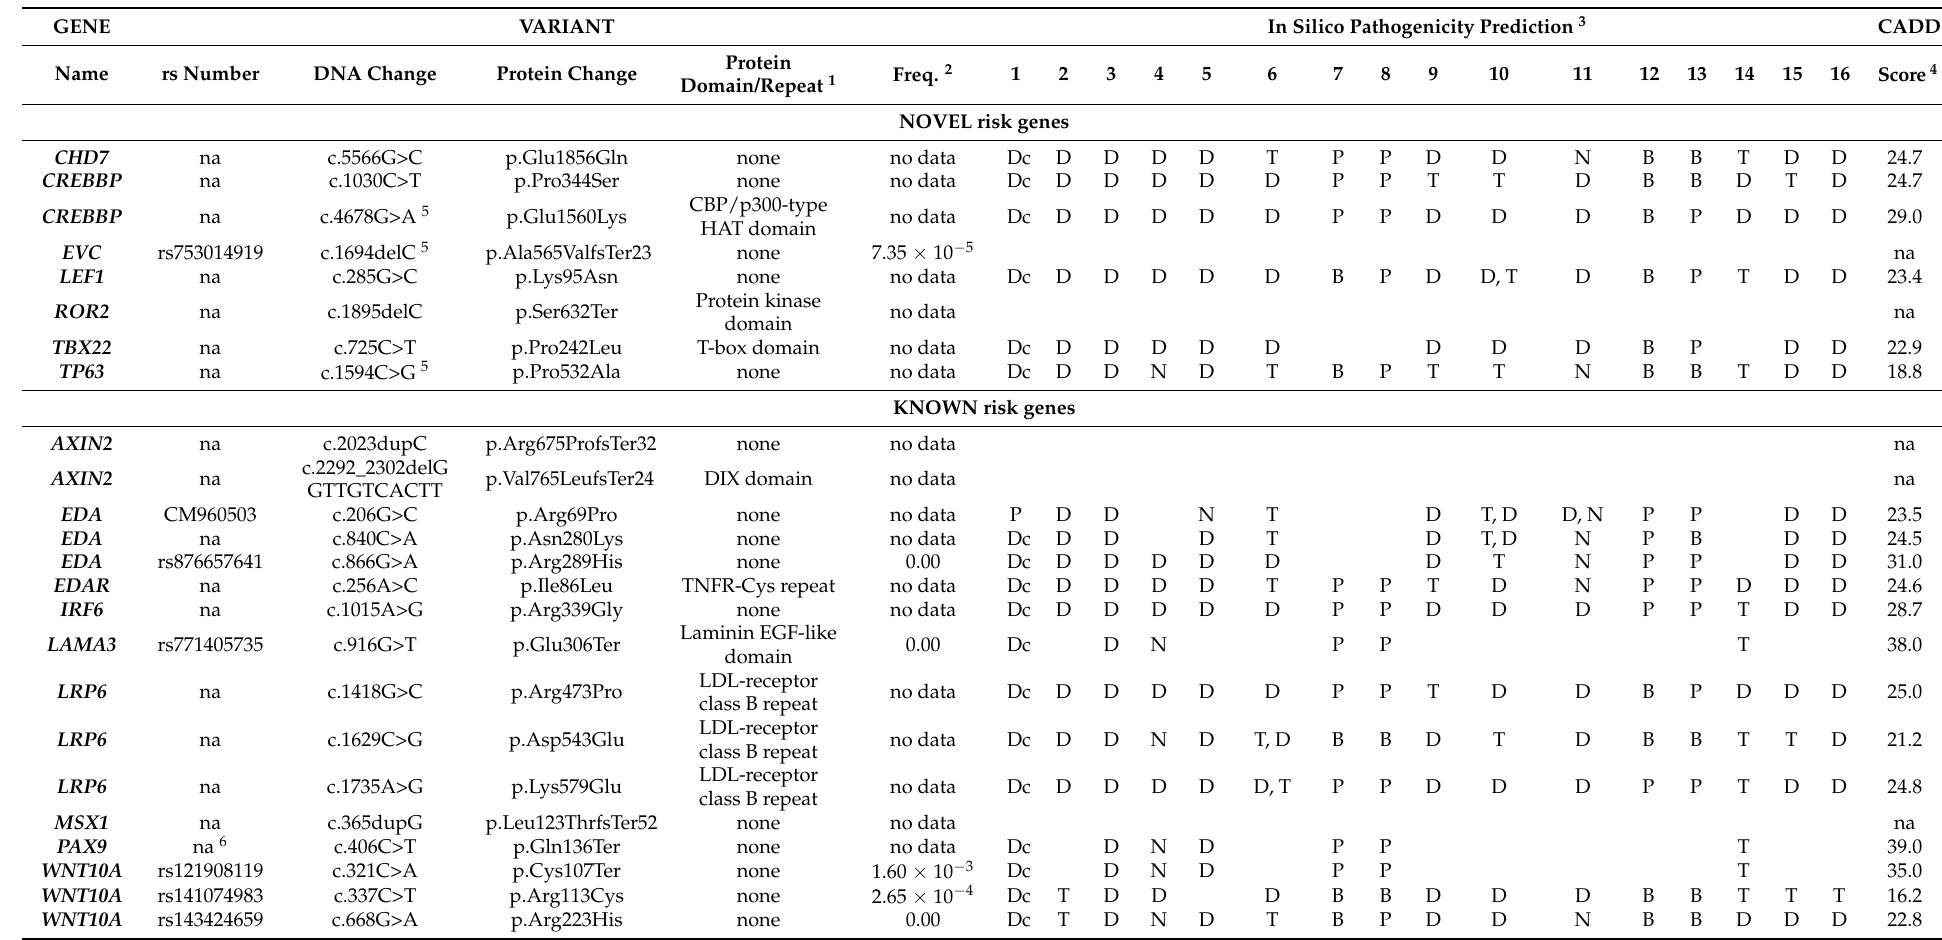
Table 2. Characteristics of variants identified in patients with